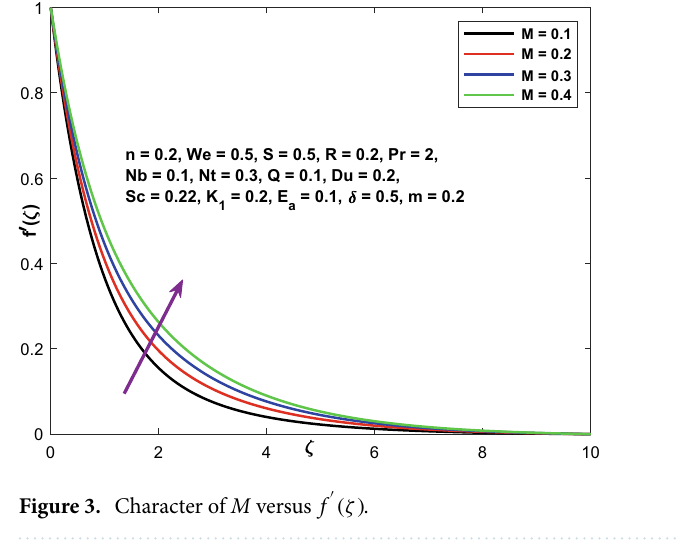
Figure 3. Character of M versus f ′ (ζ)